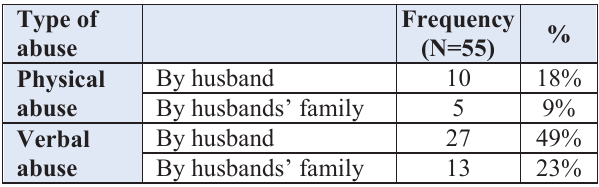
Table-3: Type of abuse during pregnancy